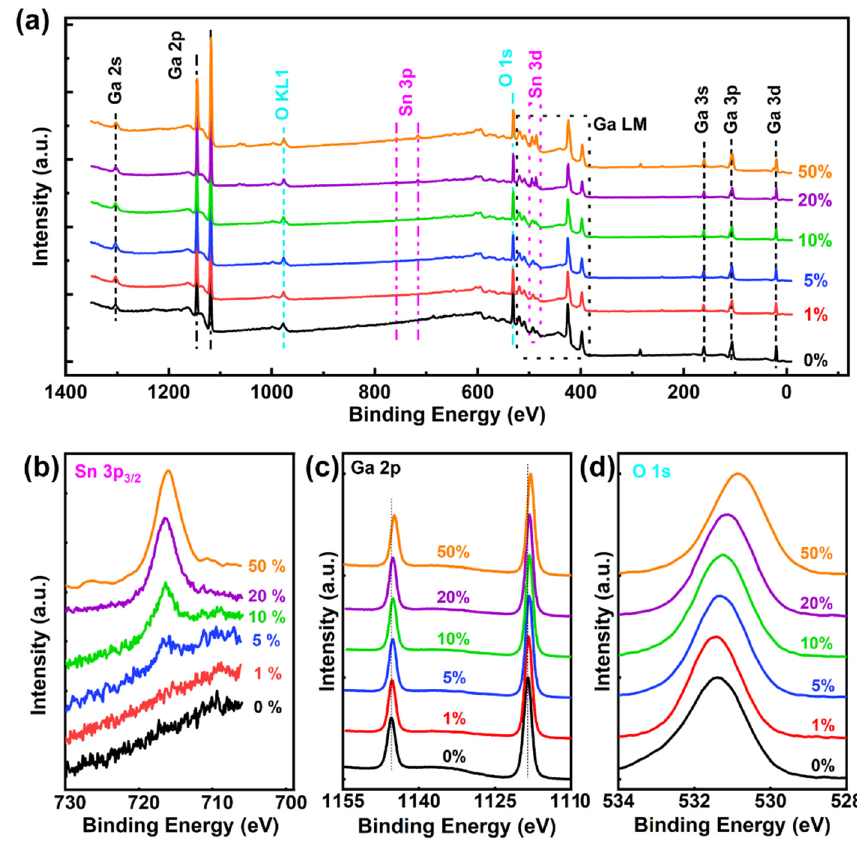
Figure 2. Graphs depicting the results of the XPS analysis for the Ga 2 O 3 thin films with 0%, 1%, 5%, 10%, 20%, and 50% Sn compositions: ( a ) survey peaks, ( b ) Sn 3p 3/2 spectra, ( c ) Ga 2p spectra, and ( d ) O 1s spectra.